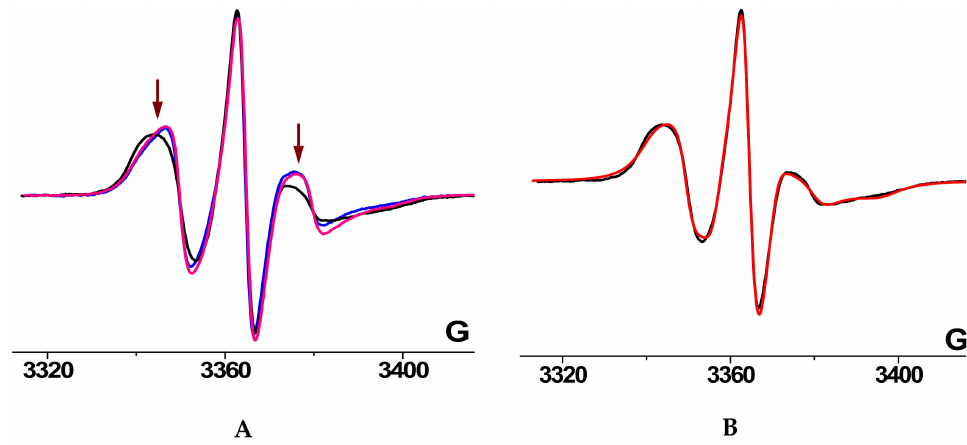
Figure 5. EPR spectra changes after annealing at 140 ◦ C. ( A ) EPR spectra of TEMPO radical in PHB samples containing 5% TPP, before annealing (blue line) and after annealing for 90 (pink line) and 240 min (black line). The spectra are normalized to the intensity of the central component; the arrows indicate the regions of the greatest change in the line shape. ( B ) Spectrum simulation for the samples annealed for 240 min (black line—experimental spectrum, red line—simulation result).